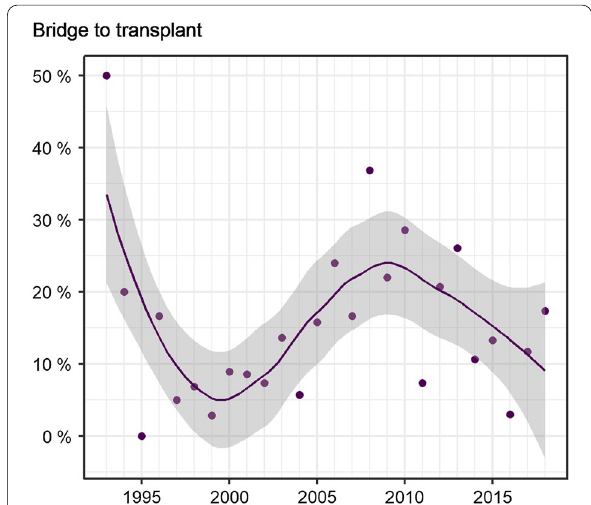
Fig. 2 Bridge to transplant. Share of TIPS implantations performed in patients waiting for a liver transplant (14.0% of total study population ( n 117)). Note fluctuation over the course of =